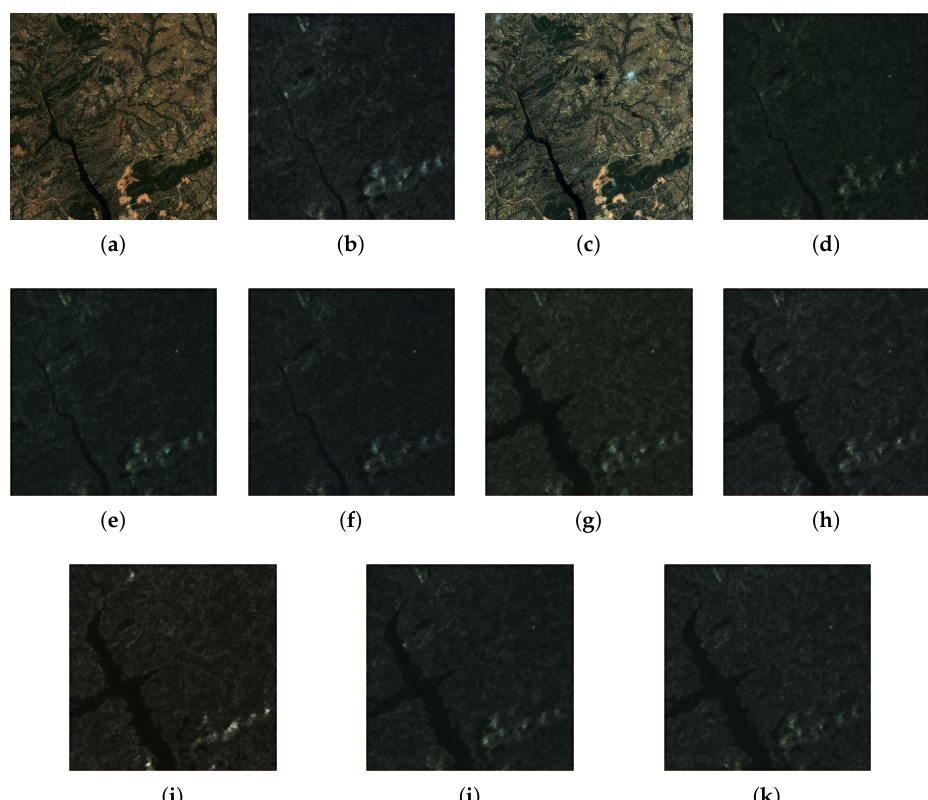
Figure 7. Original and generated SITS in the optical domain: ( a ) 1 February 2019, ( b ) 4 February 2019,